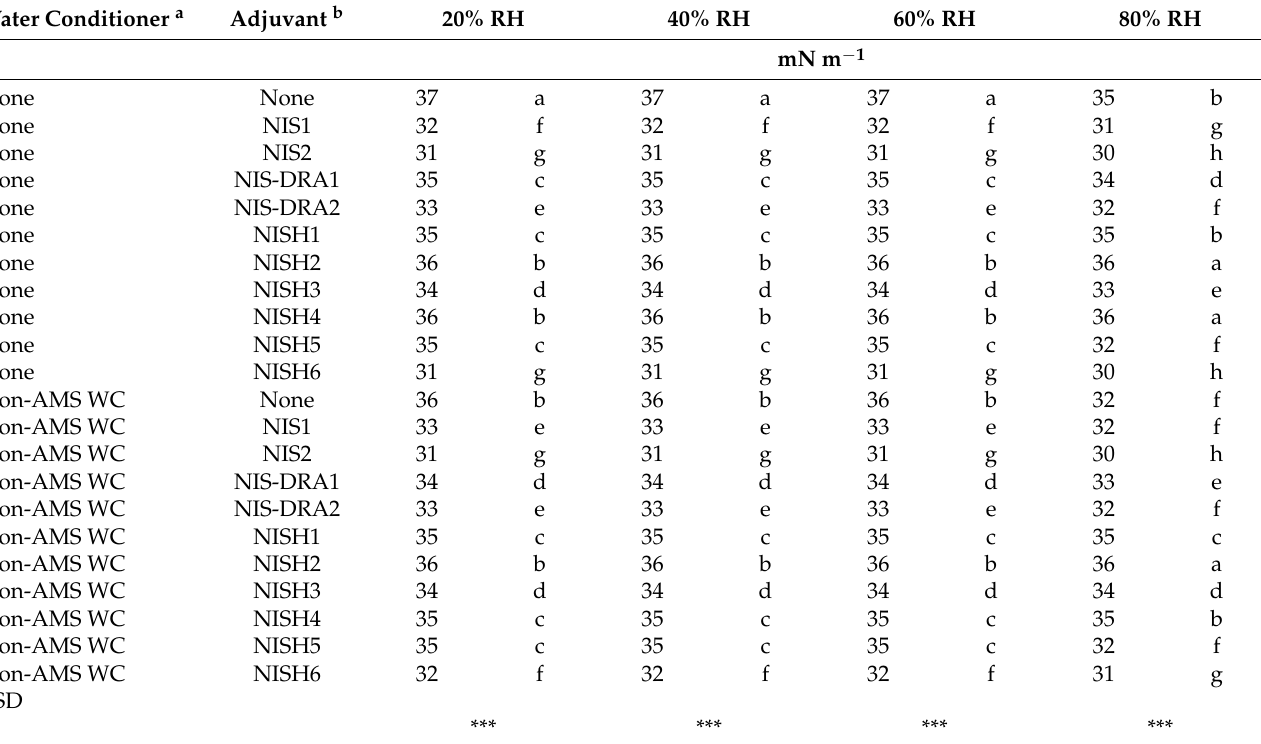
Table 4. Dynamic surface tension for dicamba plus glyphosate solutions at 559 and 1541 g ae ha − 1 , respectively, with and without non-AMS water conditioner alone and tank mixed with 10 adjuvants at 25 ◦